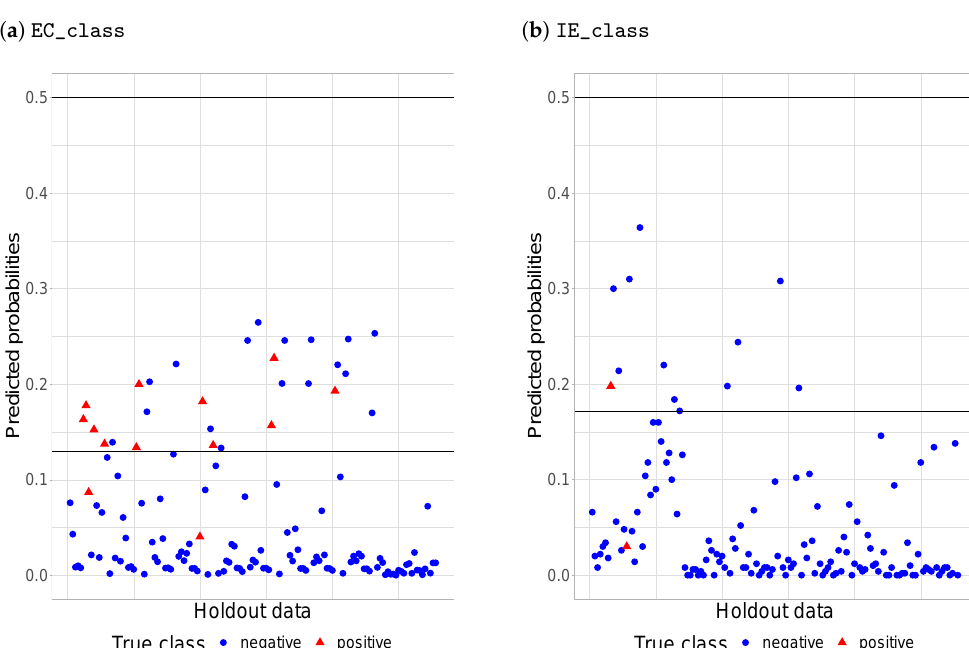
Figure 11. Classification probabilities of samples and probabilities thresholds. Red triangles represent the actual positive class and blue dots the actual negative class. Horizontal lines represent a default classification threshold of 0.5 and adjusted thresholds of 0.130 for EC_class and 0.172 for IE_class